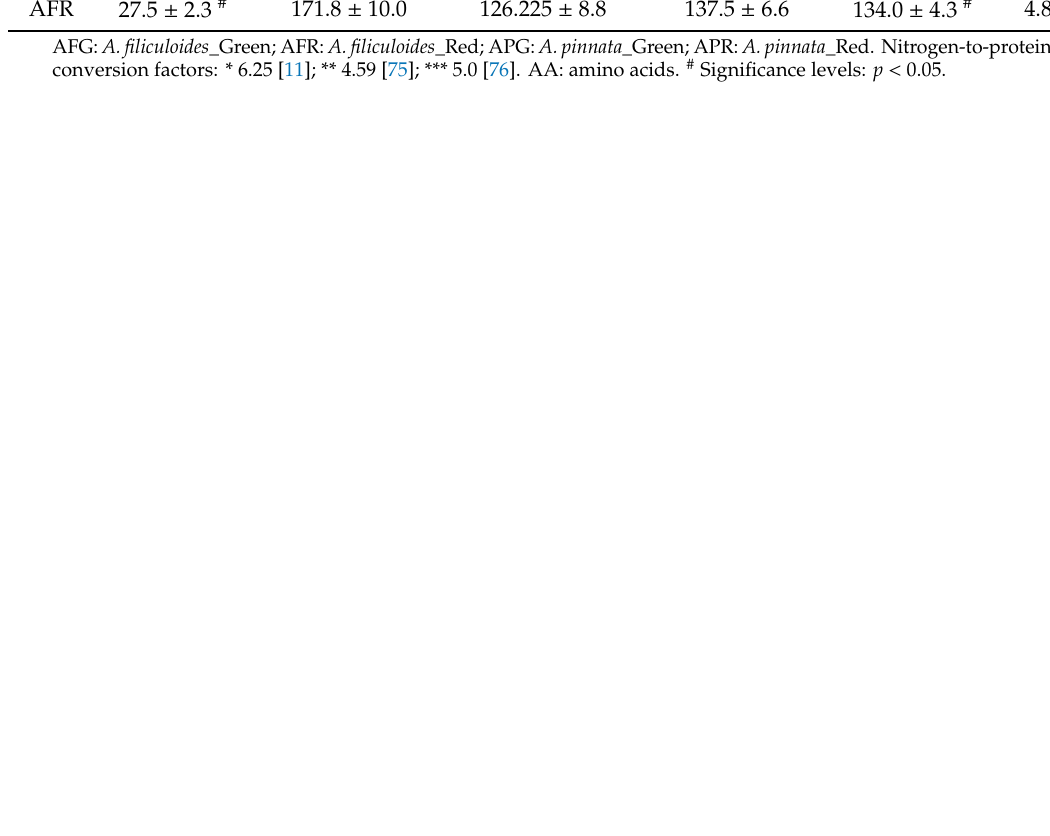
Table 1. Concentrations of nitrogen, total amino acids (AA) and proteins in A. filiculoides and A. pinnata . Total N Total Protein *, Total Protein **, Total Protein Total AA, N-Prot mg / g DW mg / g DW mg / g DW ***, mg / g DW mg / g Factor AFG 38.1 ± 2.5 # 237.5 ± 22.2 174.42 ± 12.1 190 ± 9.1 205.3 ± 8.1 # 5.40 AFR 26.4 ± 3.2 # 165 ± 8.3 121.176 ± 10.1 132 ± 10.8 46.0 ± 4.1 # 287.5 ± 15.4 211.14 ± 14.4 230 ± 18.5 265.0 ± 10.4 # 5.76 AFR 27.5 ± 2.3 # 171.8 ± 10.0 126.225 ± 8.8 137.5 ± 6.6 134.0 ± 4.3 #